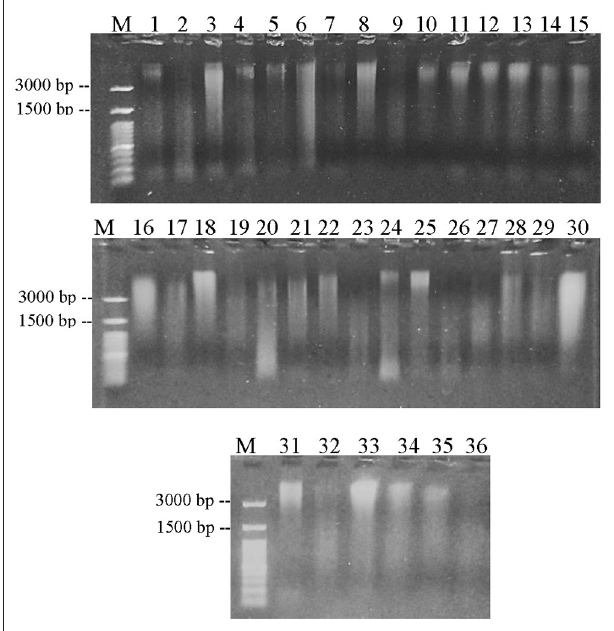
FIGURE 1 | Visualization of DNA isolated from meatball samples in Boyolali Regency and electrophoresed on a 0.8% agarose gel. The samples were numbered L1–L36. (M) DNA marker 100